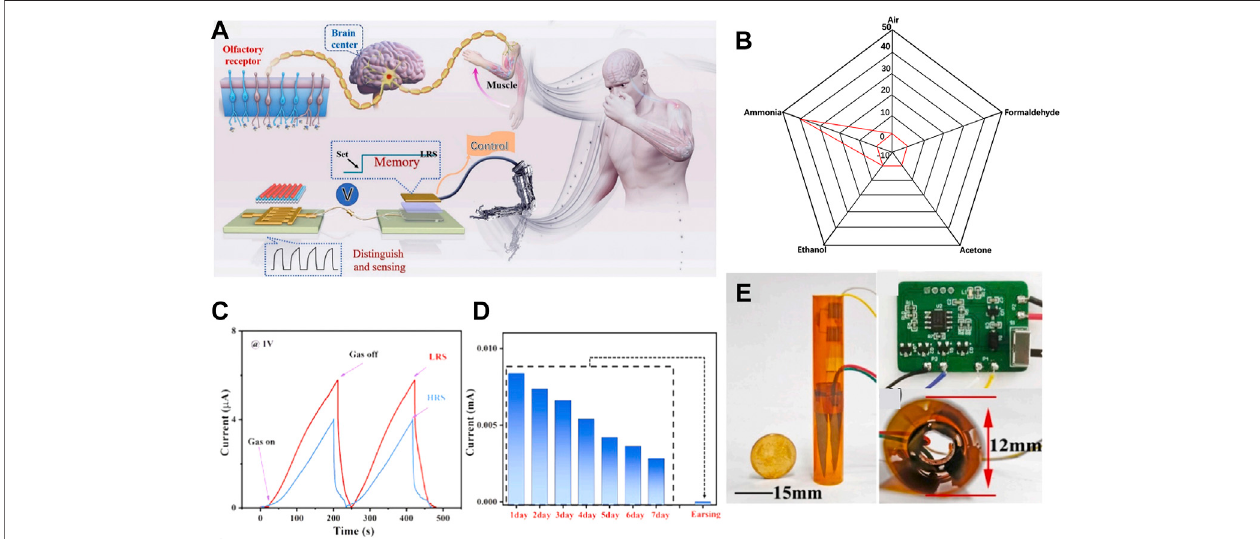
FIGURE 11 | (A) Overall comparison of the biological and arti fi cial olfactory system . (B) Selectivity of gas sensor to various testing gases at concentrations of 100 ppm. (C) Time-domainresponsesoftheolfactory memorydevicetotheHRSandLRSof5000 ppmNH 3 . (D) Memorypersistence ofolfactory memorydevices. (E) A photo of the bionic nose, a picture of its printed circuit board (PCB) and a picture of the main part and the diameter of the bionic nose (adapted from Gao et al., 2021).